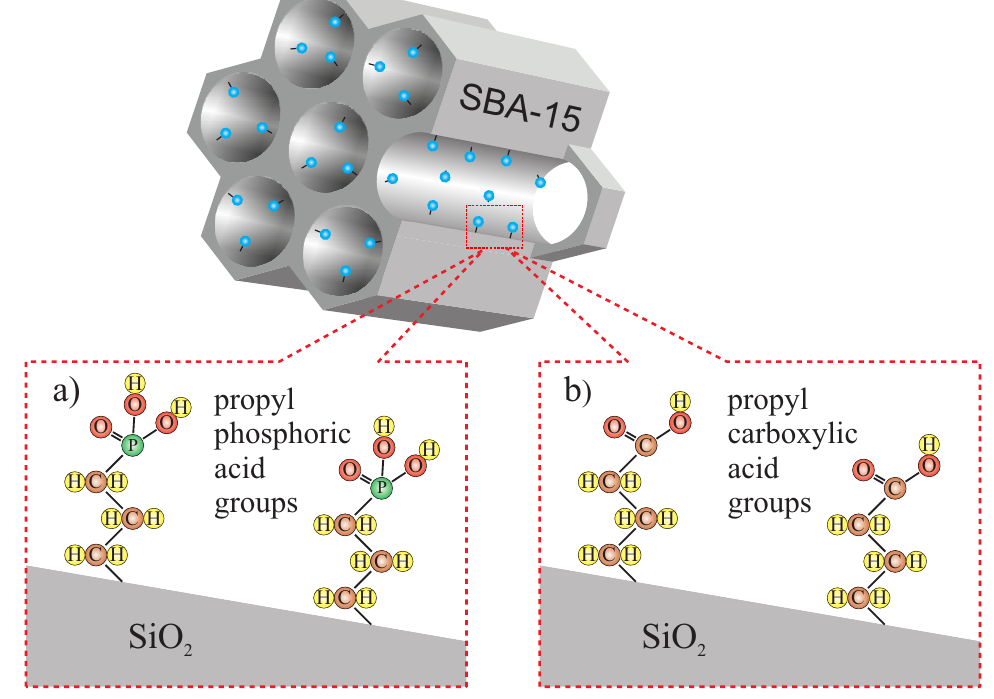
Figure 21. A schematic presentation of the SBA-15 silica functionalized with propyl phosphoric acid ( a ) and propyl carboxylic acid groups ( b